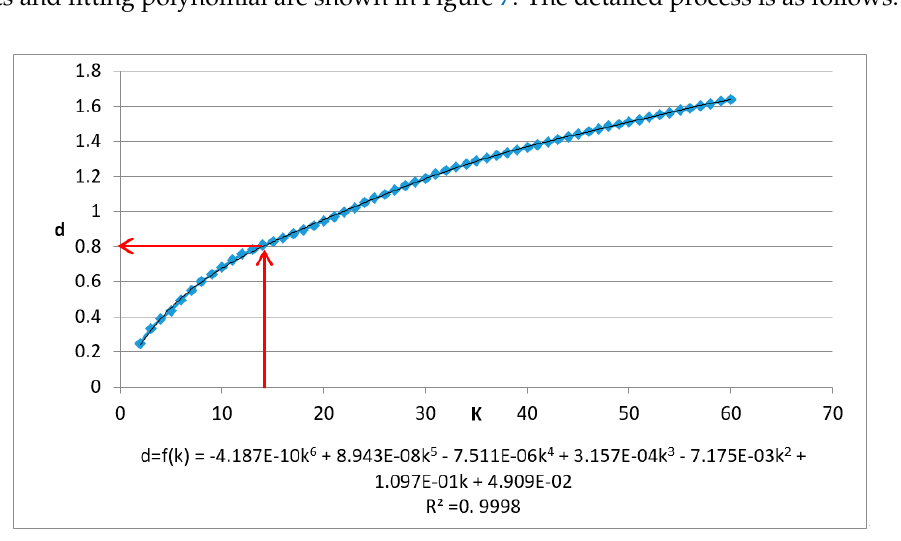
Figure 7. Chart and fitting curve of the mean max distance of k nearest neighbor of airborne laser scanning data using X , Y , Z fields.